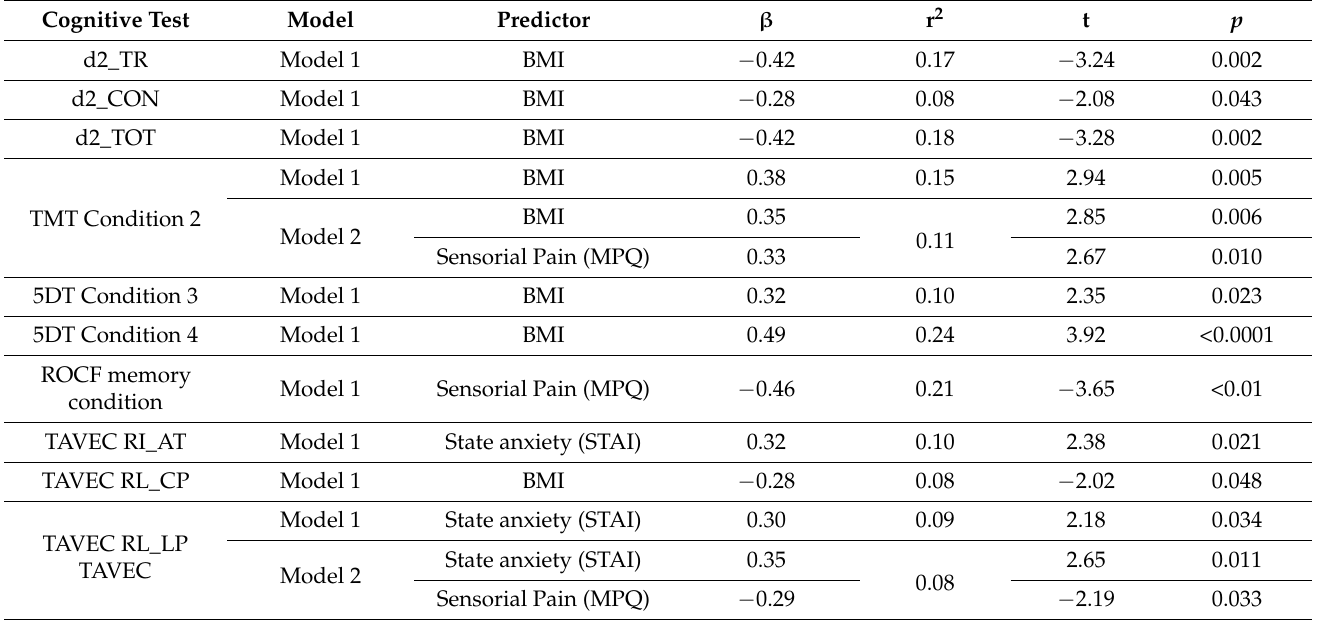
Table 3. Results of multiple regression analysis performed to determine the ability of clinical factors and BMI to predict cognitive performance in FM